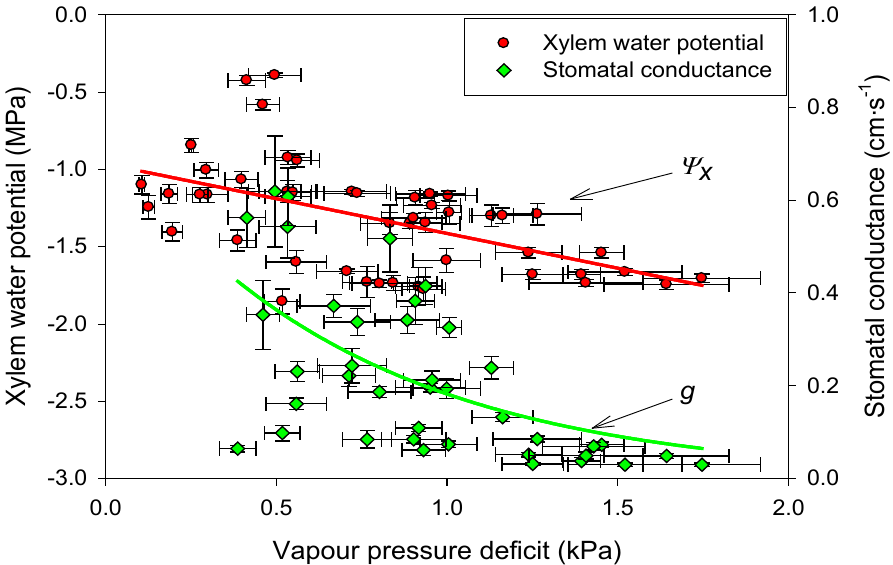
Figure 5. Relationships between midday xylem water potential and midday stomatal conductance as a function of vapour pressure deficit (VPD) in Abies pinsapo trees along an altitudinal gradient (low elevation, 1200 m; high elevation, 1550 m) measured during two consecutive growing periods. Errors bars represent the standard error. Midday xylem water potential showed a linear relationship ( R 2 = 0.29, p < 0.001), while midday stomatal conductance showed an exponential relationship ( R 2 = 0.36, p < 0.001)with